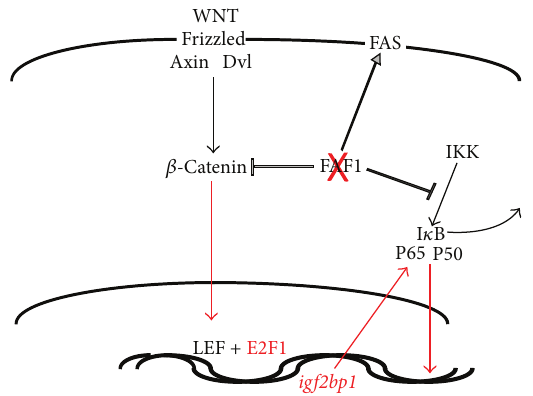
Figure 5: Possible transforming pathway. The point mutation in FAF1 is believed to cause a loss of function (crossed out in red). This may lead to an overactivity of the WNT signaling pathway. Consistently, E2F1 (activated by LEF1) and igf2bp1 (a transcriptional target of the WNT pathway) have been identified to be upregulated in the molecular analysis. In contrast to the negative regulator FAF1, IGF2BP1 is a positive regulator of NF- 𝜅 B activity. The overactivity of the NF- 𝜅 B pathway and the reduced efficacy of FAS signaling can be